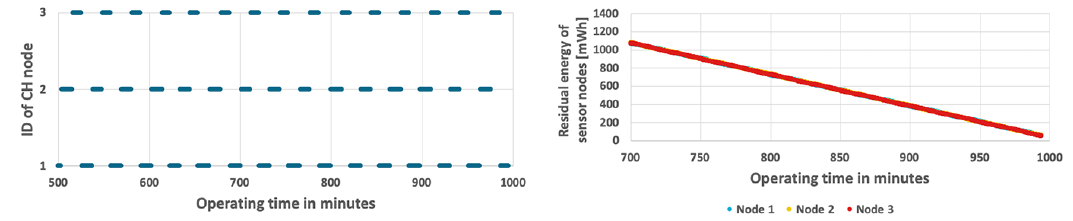
Figure 11. Energy consumption by sensor nodes for the proposed algorithm and fixed probability of event occurrence.